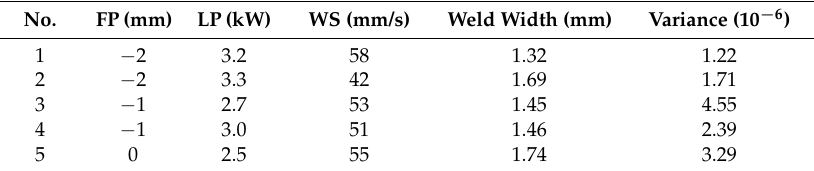
Table 4. Weld bead of additional test points.